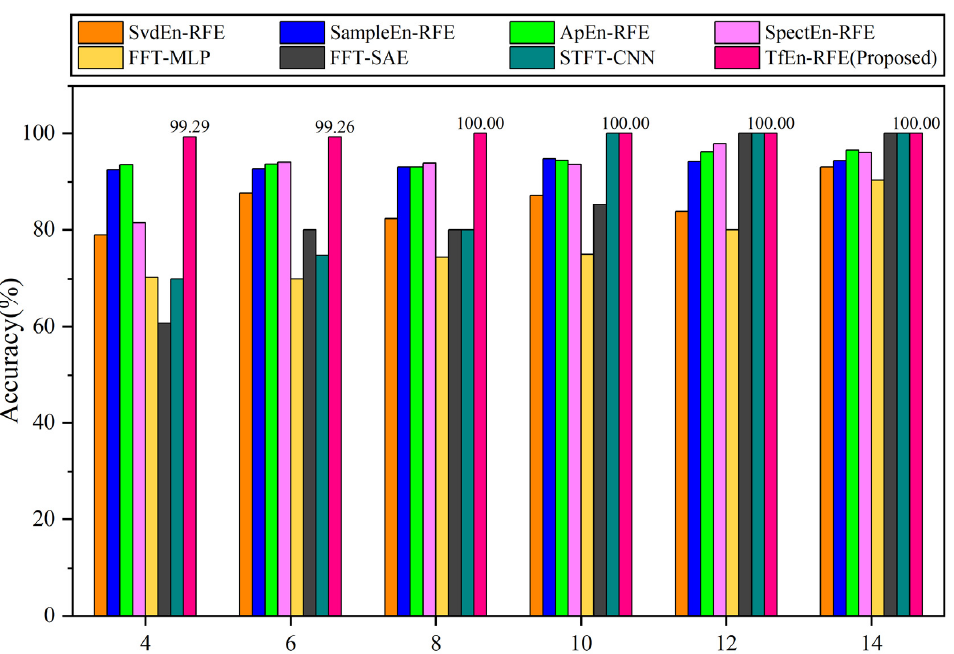
Figure 12. Comparisons among entropy and DNN-based methods with various training samples.